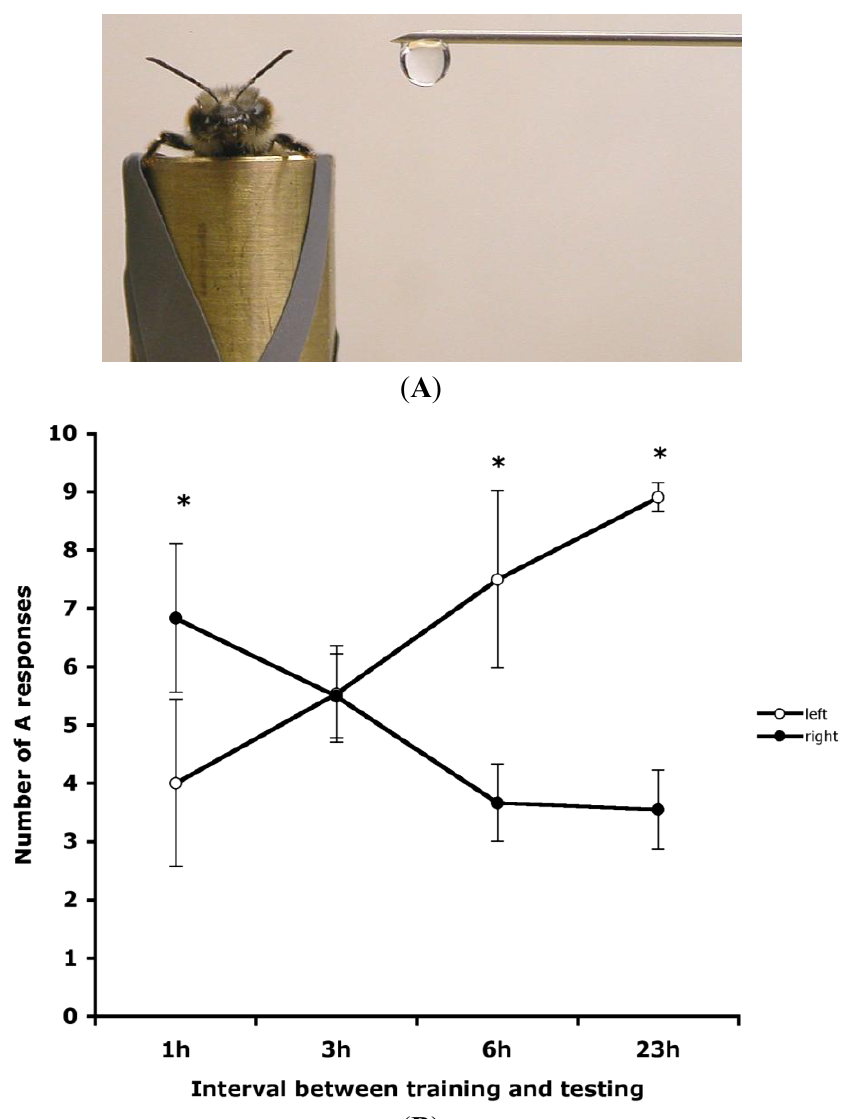
of A responses ( i.e. , extension of the proboscis to the positive stimulus and no extension to the negative stimulus), plotted with standard error bars, in recall tested at various intervals (cid:68)(cid:73)(cid:87)(cid:72)(cid:85)(cid:3)(cid:87)(cid:85)(cid:68)(cid:76)(cid:81)(cid:76)(cid:81)(cid:74)(cid:3)(cid:76)(cid:86)(cid:3)(cid:86)(cid:75)(cid:82)(cid:90)(cid:81)(cid:3)(cid:73)(cid:82)(cid:85)(cid:3)(cid:83)(cid:85)(cid:72)(cid:86)(cid:72)(cid:81)(cid:87)(cid:68)(cid:87)(cid:76)(cid:82)(cid:81)(cid:86)(cid:3)(cid:82)(cid:73)(cid:3)(cid:87)(cid:75)(cid:72)(cid:3)(cid:82)(cid:71)(cid:82)(cid:88)(cid:85)(cid:86)(cid:3)(cid:82)(cid:81)(cid:3)(cid:87)(cid:75)(cid:72)(cid:3)(cid:69)(cid:72)(cid:72)(cid:182)(cid:86)(cid:3)(cid:79)(cid:72)(cid:73)(cid:87)(cid:3)(cid:86)(cid:76)(cid:71)(cid:72)(cid:3)(cid:11)(cid:82)(cid:83)(cid:72)(cid:81)(cid:3)(cid:70)(cid:76)(cid:85)(cid:70)(cid:79)(cid:72)(cid:86)(cid:12)(cid:3) or right side (closed circles). (From